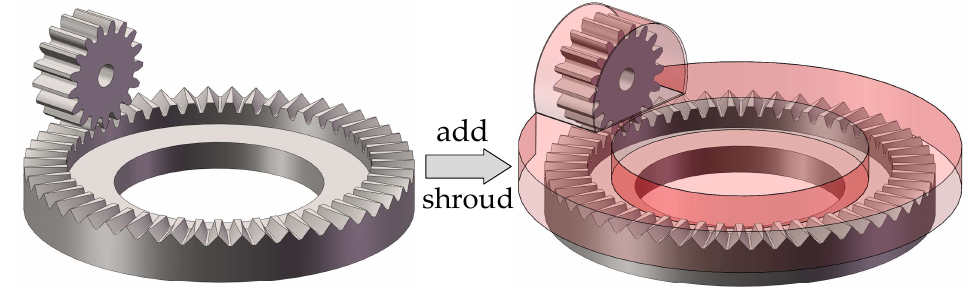
Figure 19. Recommended shroud for face gear drive.